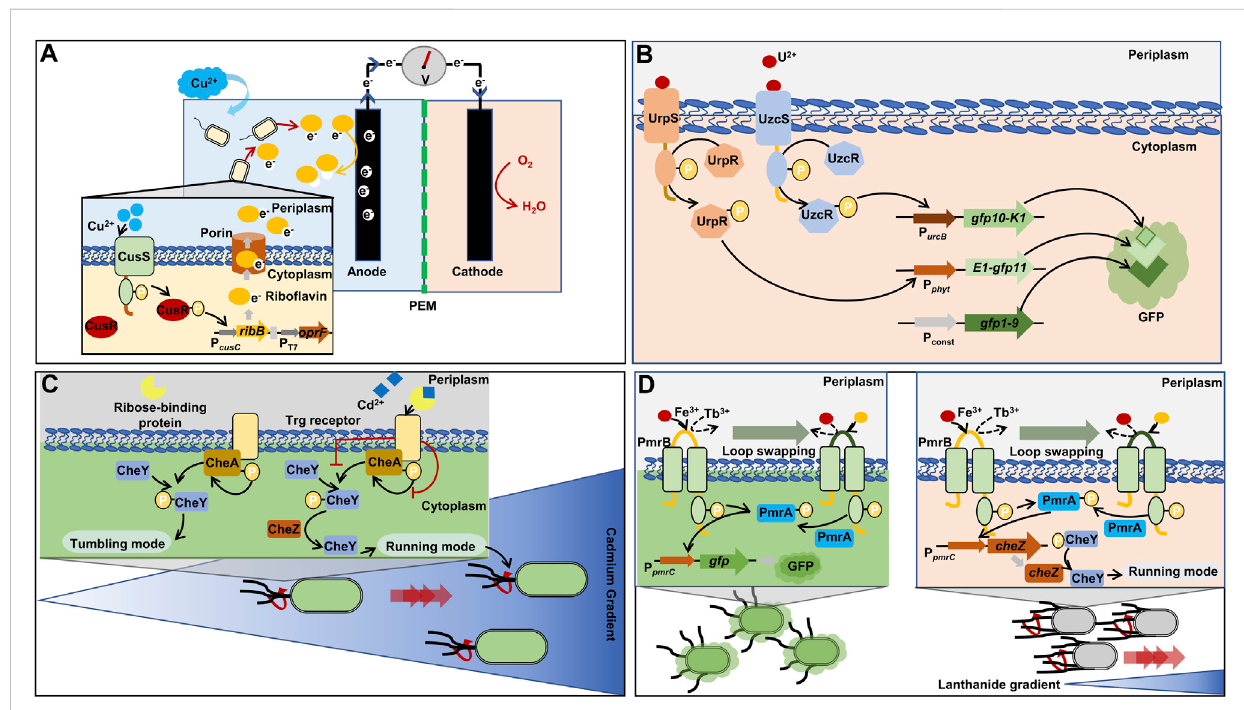
FIGURE 4 Representative synthetic biology approaches for two-component regulatory system (TCRS)-based whole-cell biosensors. (A) Rapid and inexpensive electrical detection of cooper by ribo fl avin as an output signal (Zhou et al., 2021). (B) Combination of two TCRS systems for the speci fi c detection of uranium and tripartite green fl uorescent protein cooperation (Park and Taffet, 2019). (C) Chemotaxis towards cadmium via retailored ribose binding protein for cadmium binding (Li et al., 2022a). (D) Formation of a lanthanide-sensing component by exchanging iron-binding motif of histidine kinase with lanthanide-binding peptide (Liang et al., 2013). cheZ : phosphatase; gfp : green fl uorescent protein; gfp10 : β -strand 10 of green fl uorescent protein; gfp11 : β -strand 11 of green fl uorescent protein; gfp1-9 : β -strand from 1 to 9 of green fl uorescent protein; oprF : outer membrane porin F; ribB : 3,4-dihydroxy-2-butanone-4-phosphate synthase; CheA: histidine kinase; CheY: chemotaxis protein; CusR: cooper-transcriptional regulator; CusS: cooper-sensing histidine kinase; K1, E1: synthetic coiled-coils; P const : strong, constitutive promoter derived from rsaA gene encoding S-layer protein; P cusC : promoter derived cusC gene encoding ef fl ux system protein and activated by phosphorylated CusR; PEM: proton exchange membrane; PmrA: iron-transcriptional regulator; PmrB: iron-sensing protein; P phyt : promoter derived from phytase-encoded operon and activated by phosphorylated UrpR; P pmrC : promoter obtained from pmrC gene encoding phosphoethanolamine transferase and activated by phosphorylated